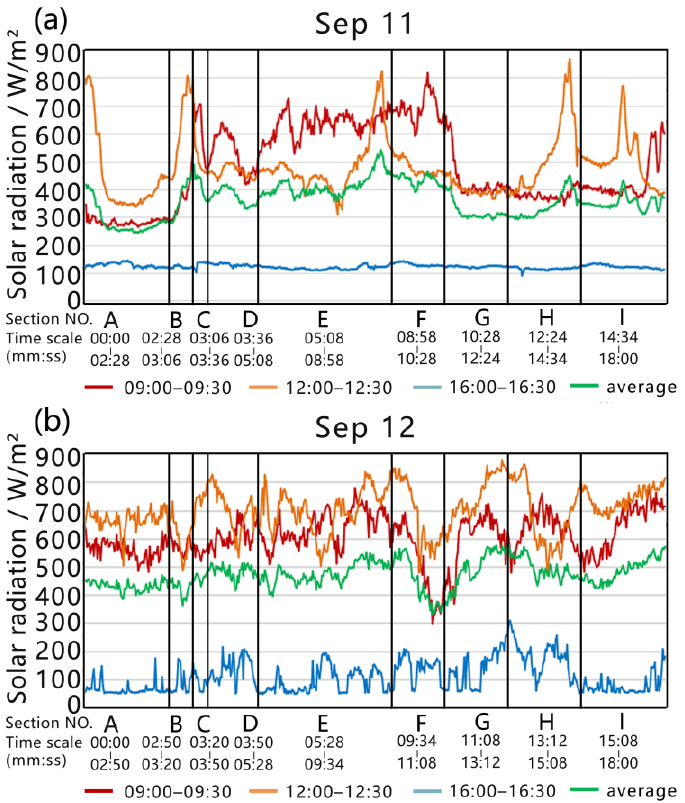
Figure 10. The line charts depicting the solar radiation changes over three time periods on 11 September ( a ) and 12 September ( b ). Table 3. The Spearman correlation analysis of measured